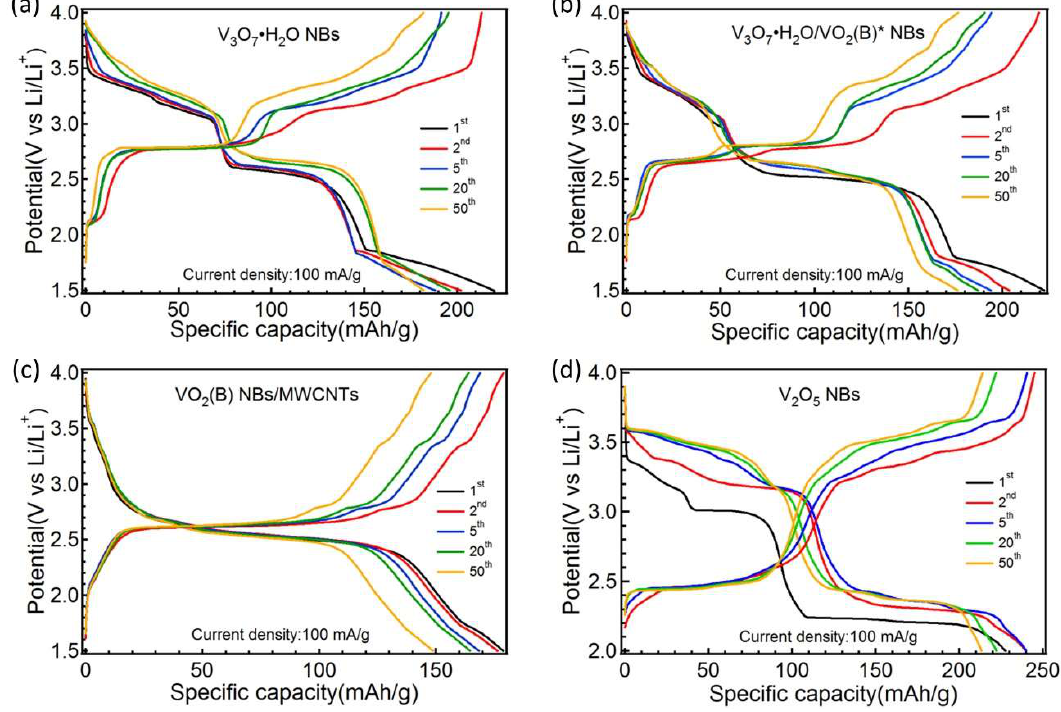
Figure 7. Galvanostatic charge/discharge profiles of V 3 O 7 ·H 2 O NBs ( a ), V 3 O 7 ·H 2 O/VO 2 (B)* NBs ( b ), VO 2 (B) NBs/MWCNTs ( c ) and V 2 O 5 NBs ( d ) under different cycles at the current density of 100 mA g −1 .